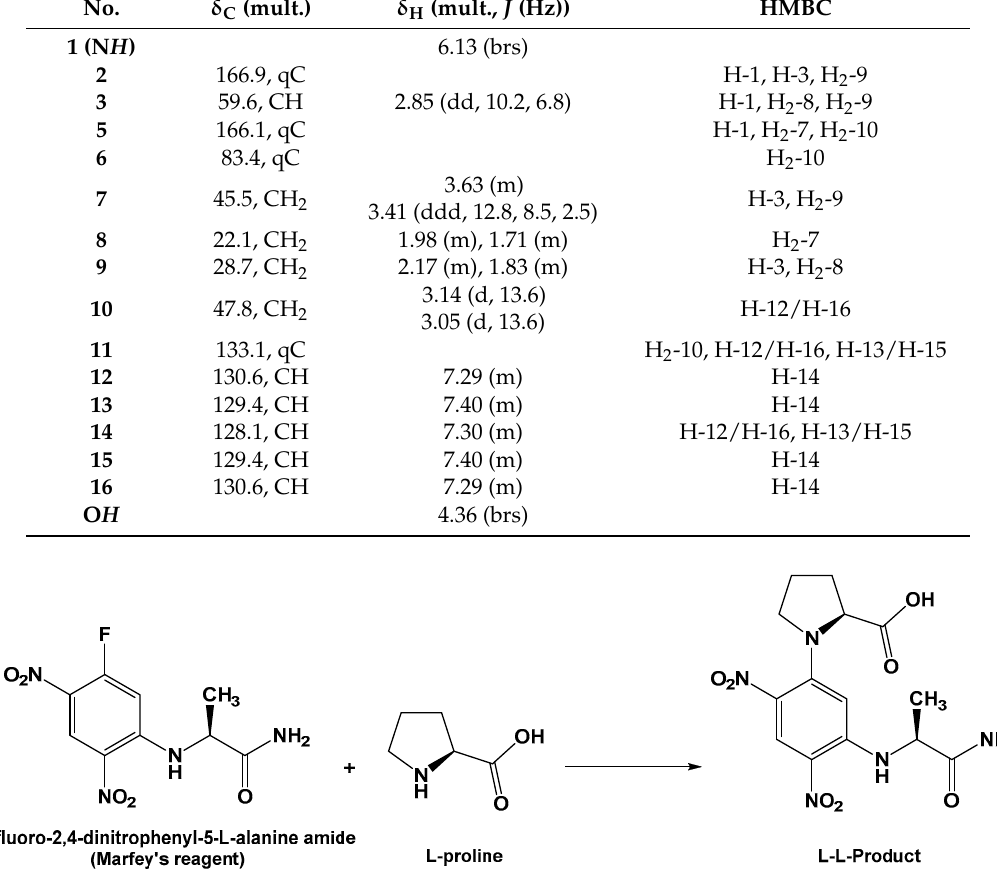
Table 2. NMR data of compound 2 (CDCl 3 , 600 and 150